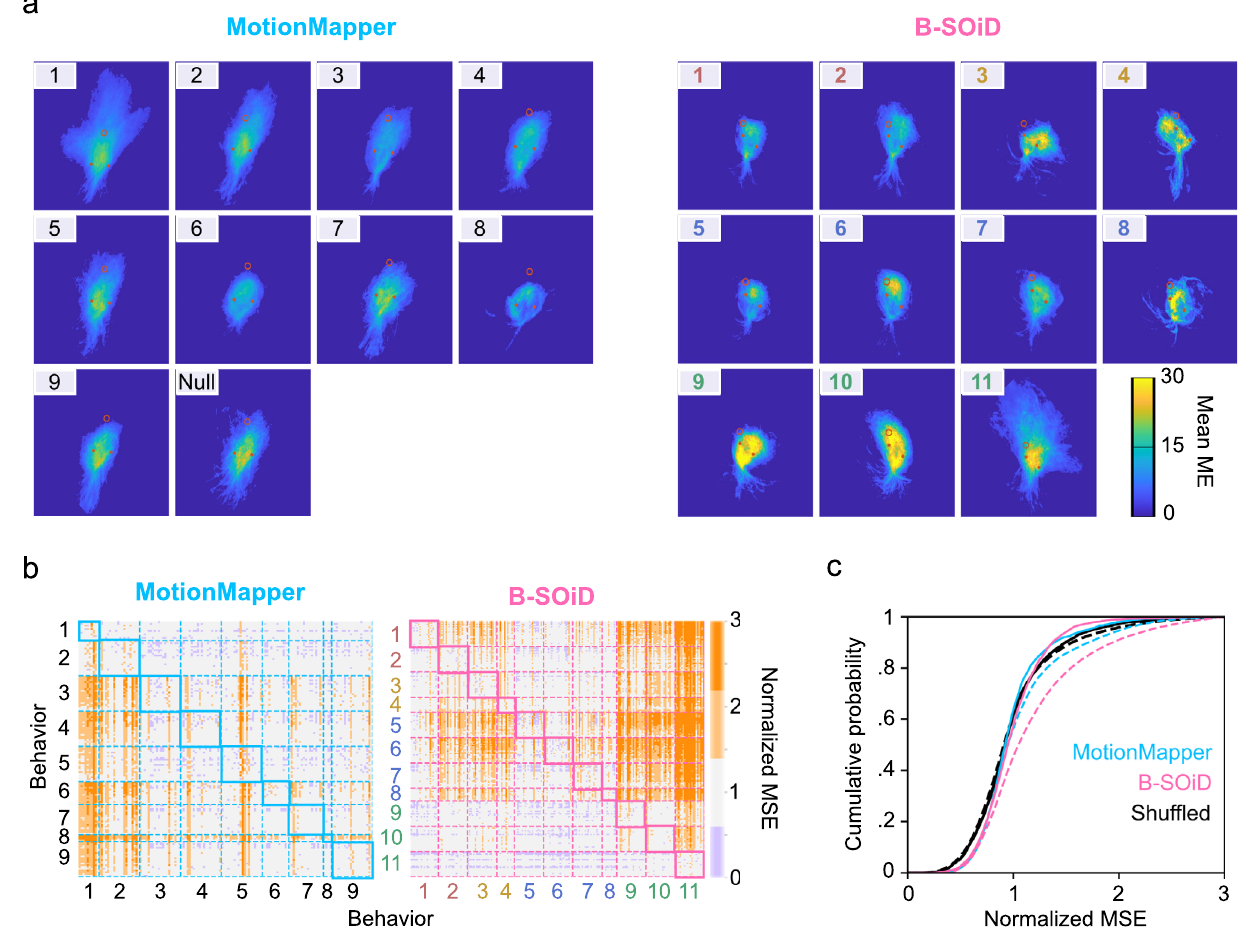
Fig. 5 Quanti fi cation of unsupervised segmentation algorithms. a Using the same pose-estimation data, we selected up to 20 bouts from each behavioral group identi fi ed by either DLC_2_MotionMapper or B-SOiD to construct motion energy (ME) images - capturing the average amount of movement across bouts. Brighter colors indicate greater consistency in movement over the 300-600ms bouts. b To quantify the quality of these groupings, we determined the difference (MSE) in motion energy across every bout, normalizing every values along a row to that row ’ s in-group mean MSE. The comparison between related, in-group bouts is shown in the highlighted diagonal. Darker orange indicates greater differences between those pairs of bouts, e.g. 2 = twice the normalized MSE. B-SOiD behavior numbers as used in Fig 1c. c Cumulative histograms of values in ( b ) for in-group (solid line) and out-group (dashed line) bouts. The same B-SOiD bouts were shuf fl ed into 11 random groups (black) to demonstrate a distribution without structure. Right-shifting of the distribution is indicative of increased differences between sample bouts. Source data are provided as a Source Data fi le for ( b , c